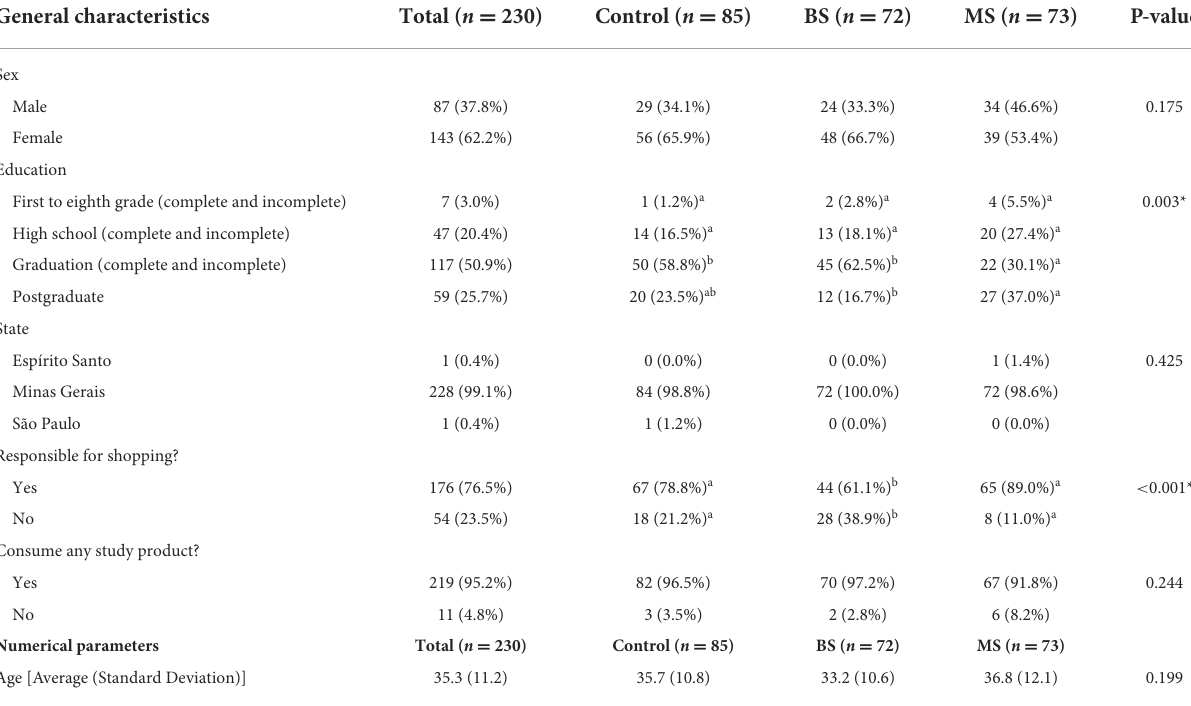
TABLE 5 General characteristics and mean and SD of the age of participants in the RotulApp application, grouped by study